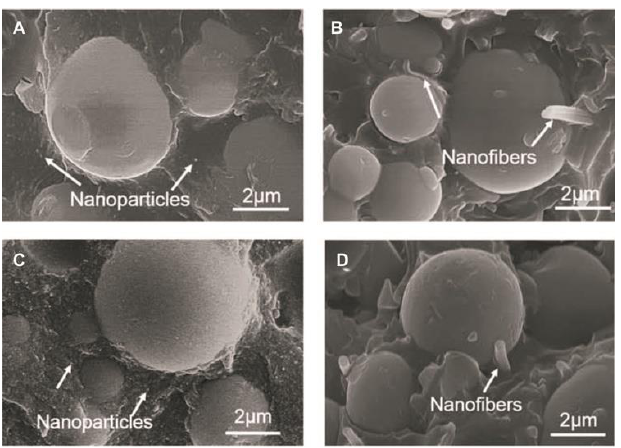
Figure 5. SEM micrographs of fractured surfaces of the Bis-GMA/TEGDMA composite reinforced with ( A ) 5 wt% SiO 2 nanoparticles and 60 wt% microparticles;( B ) 5 wt% SiO 2 nanofibers and 60 wt% microparticles;( C ) 10 wt% SiO 2 nanoparticles and 60 wt% microparticles; and ( D ) 10 wt% SiO 2 nanofibers and 60 wt% microparticles. Images from [24].